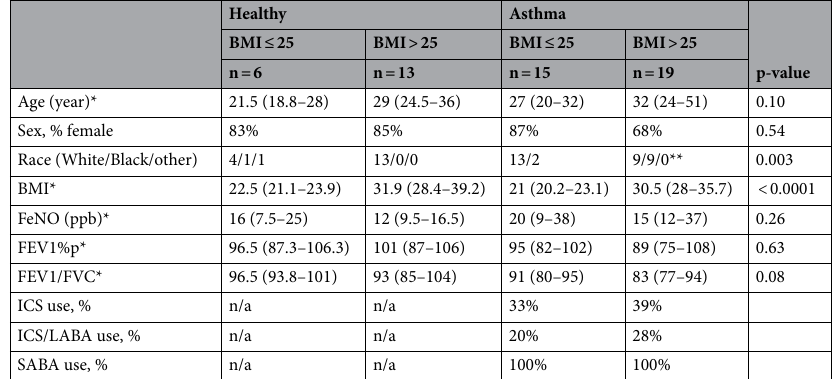
Table 1. Subject characteristics. BMI body mass index, FEV1 forced expiratory volume in 1 s, FVC forced vital capacity, FeNO fractional exhaled nitric oxide, ICS inhaled corticosteroid, LABA long-acting